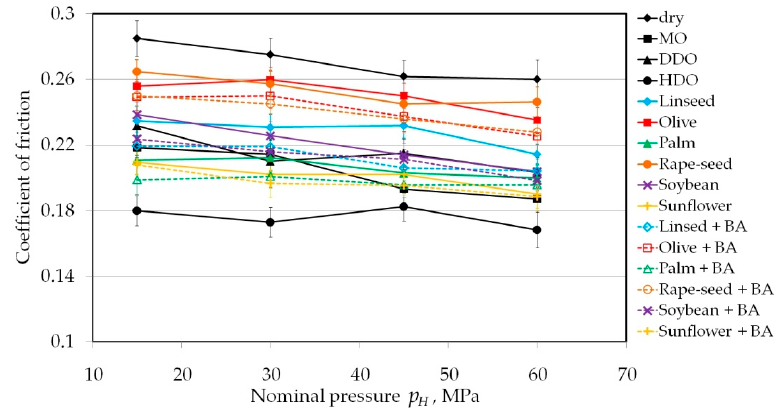
Figure 4. The effect of nominal pressure in the range between 15 and 60 MPa on the value of COF; countersample with roughness value of Ra = 0.32 mm.